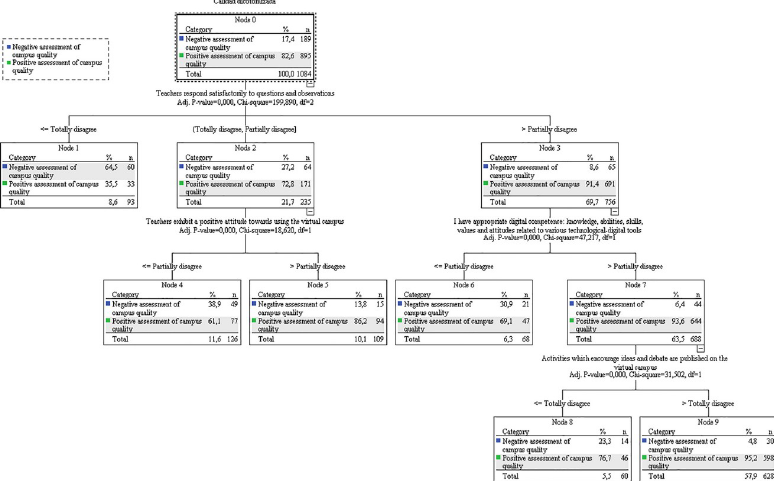
Fig 2. Decision tree referring to the use of the virtual campus as quality criteria in the teaching-learning process.